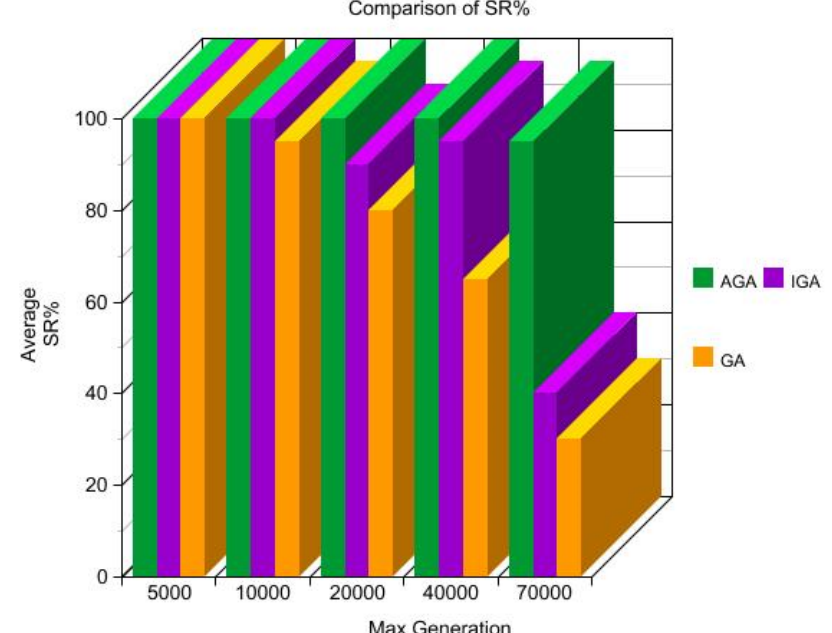
Figure 5. Comparison of success rate.